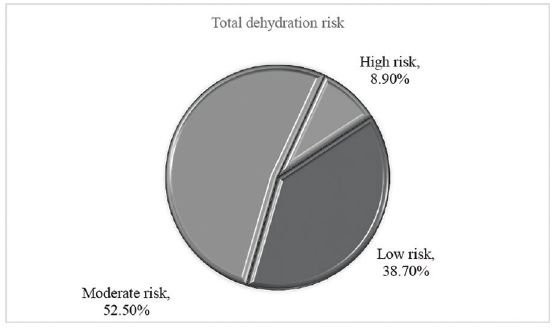
Figure 2. Distribution of the study subjects regarding total dehydration risk (N =